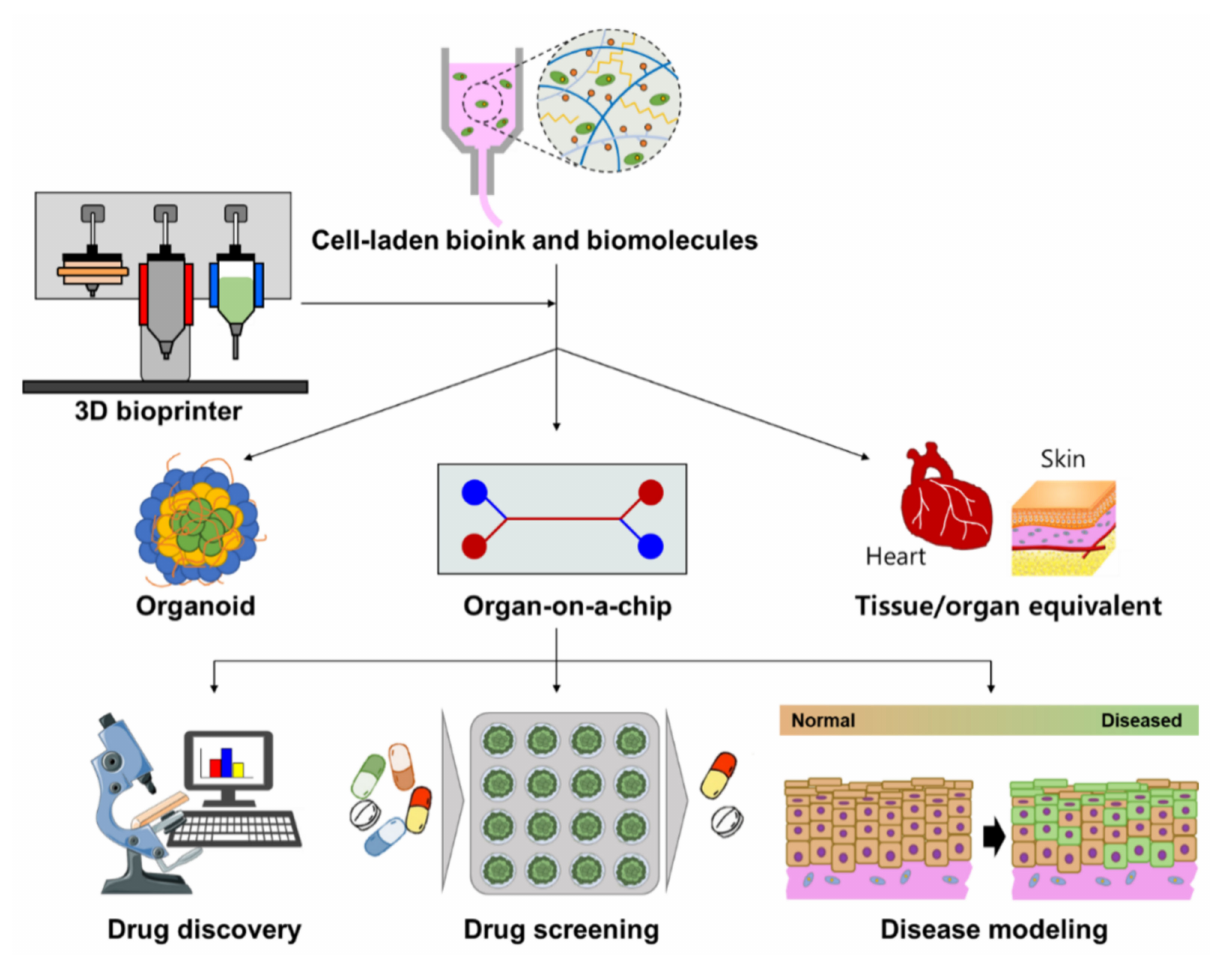
Figure 8. Pharmaceutical applications (drug-discovery, screening, and disease modeling) of 3D bio- printing. Reprinted with permission from [249]. Copyright 2021, MDPI. Distributed under Creative Commons Attribution—based license (CCBY